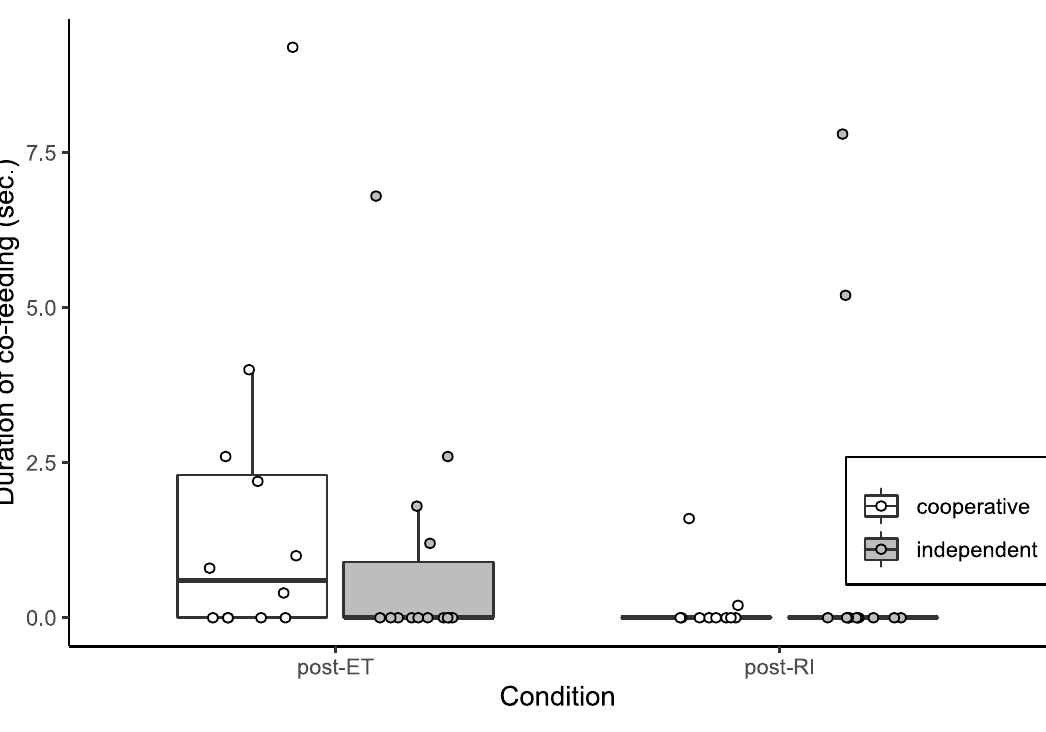
Fig 3. Duration of co-feeding between subject and partner in the food tolerance test for cooperative worker (N = 10) and independent worker (N = 12) breeds after two conditions of the paw task. Boxes display the interquartile range, black horizontal bars represent the median, whiskers represent the range of data points within 1.5 times the interquartile range from the upper and lower hinge, and circles represent individual data points. ET, equity; RI, reward inequity.